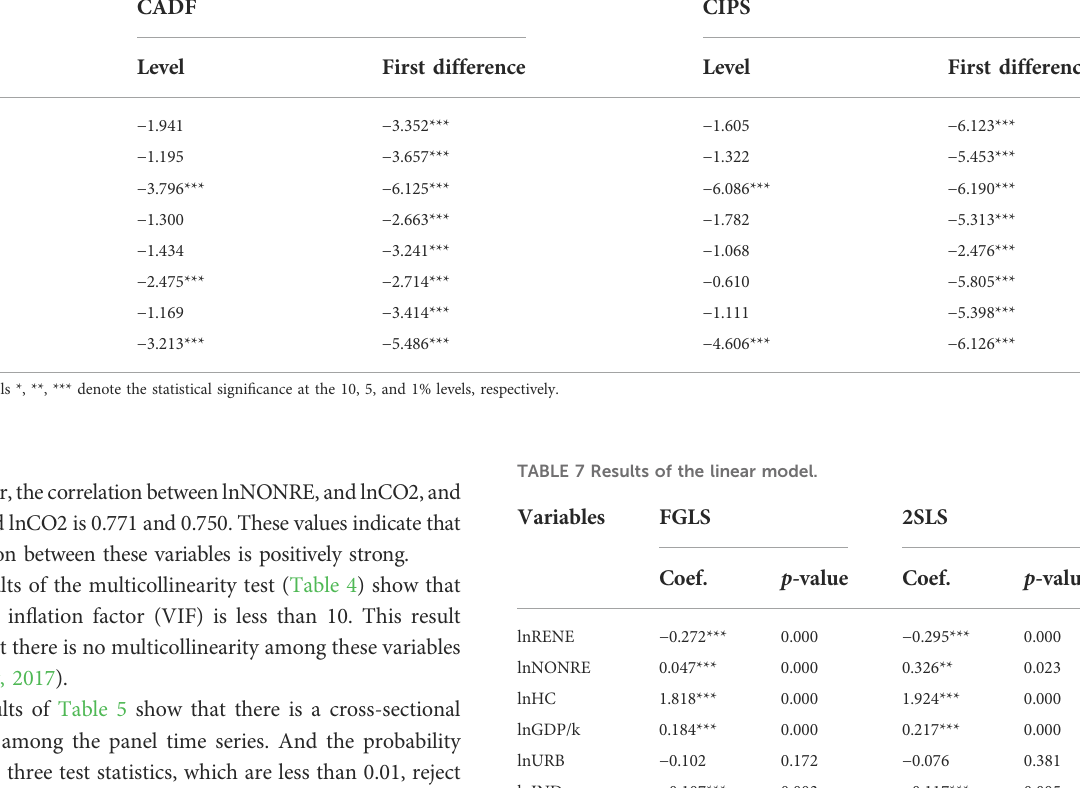
TABLE 6 The second-generation of panel unit root tests.